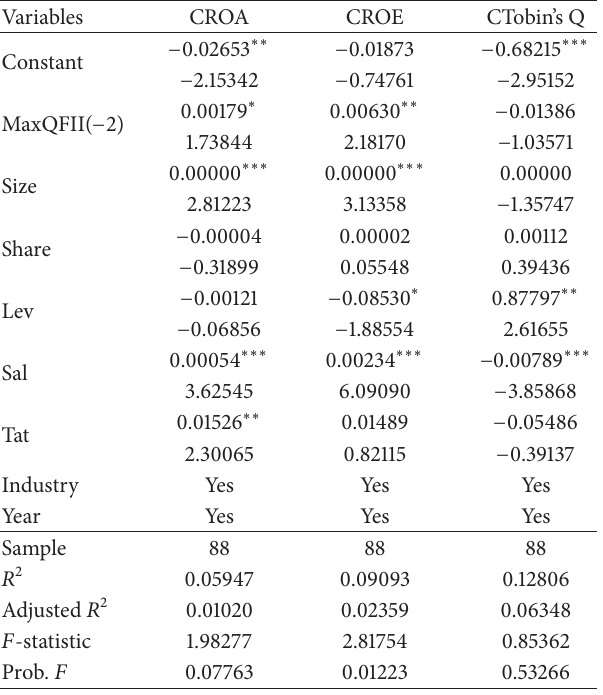
Table 9: Regression results of continuous QFII investment in period ( 𝑡 − 1 ) and company performance improvement according to MODEL III.